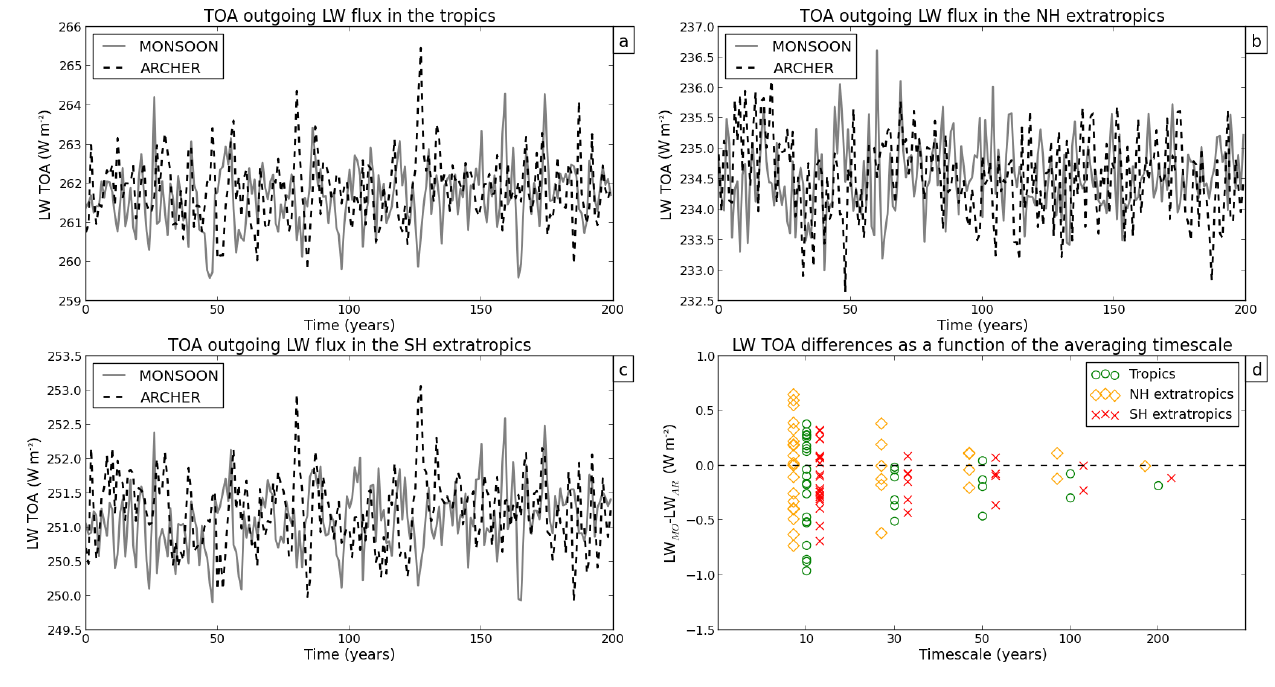
Figure 8. As in Fig. 4 but for LW TOA.